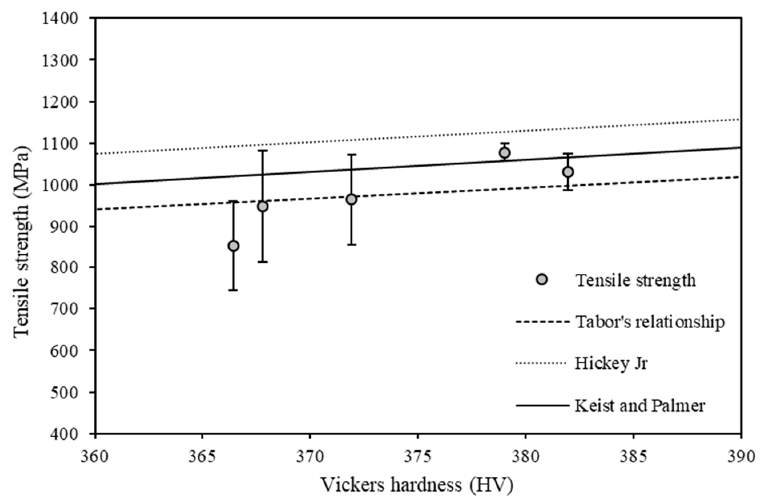
Figure 11. Mean tensile strength plotted against the mean Vickers hardness. Straight lines show the results of linear regression